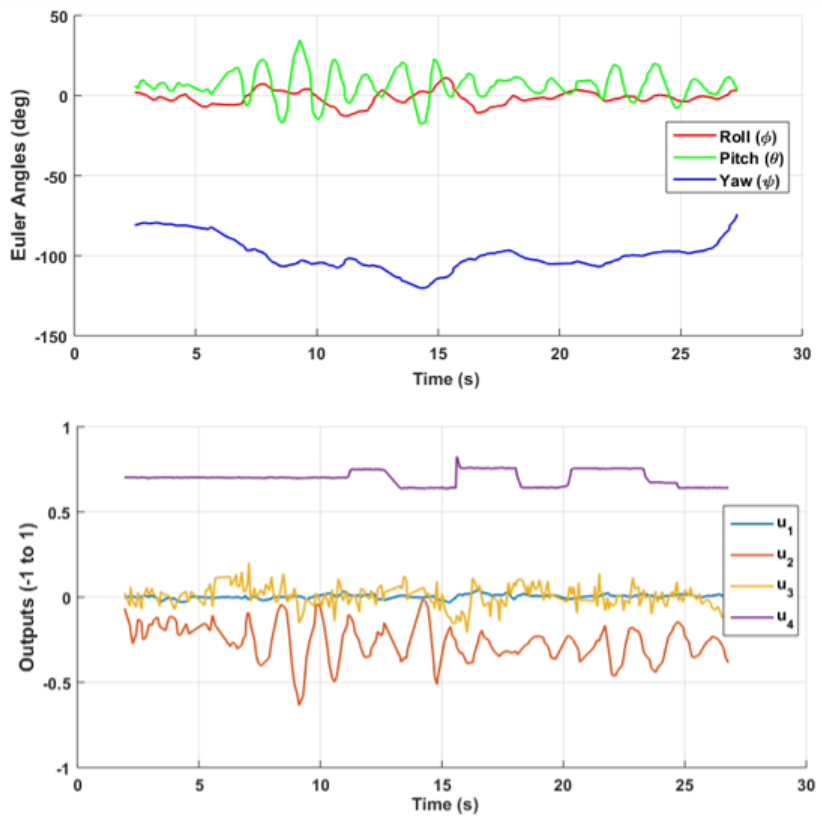
Figure 14. Time series of Euler angles and controller